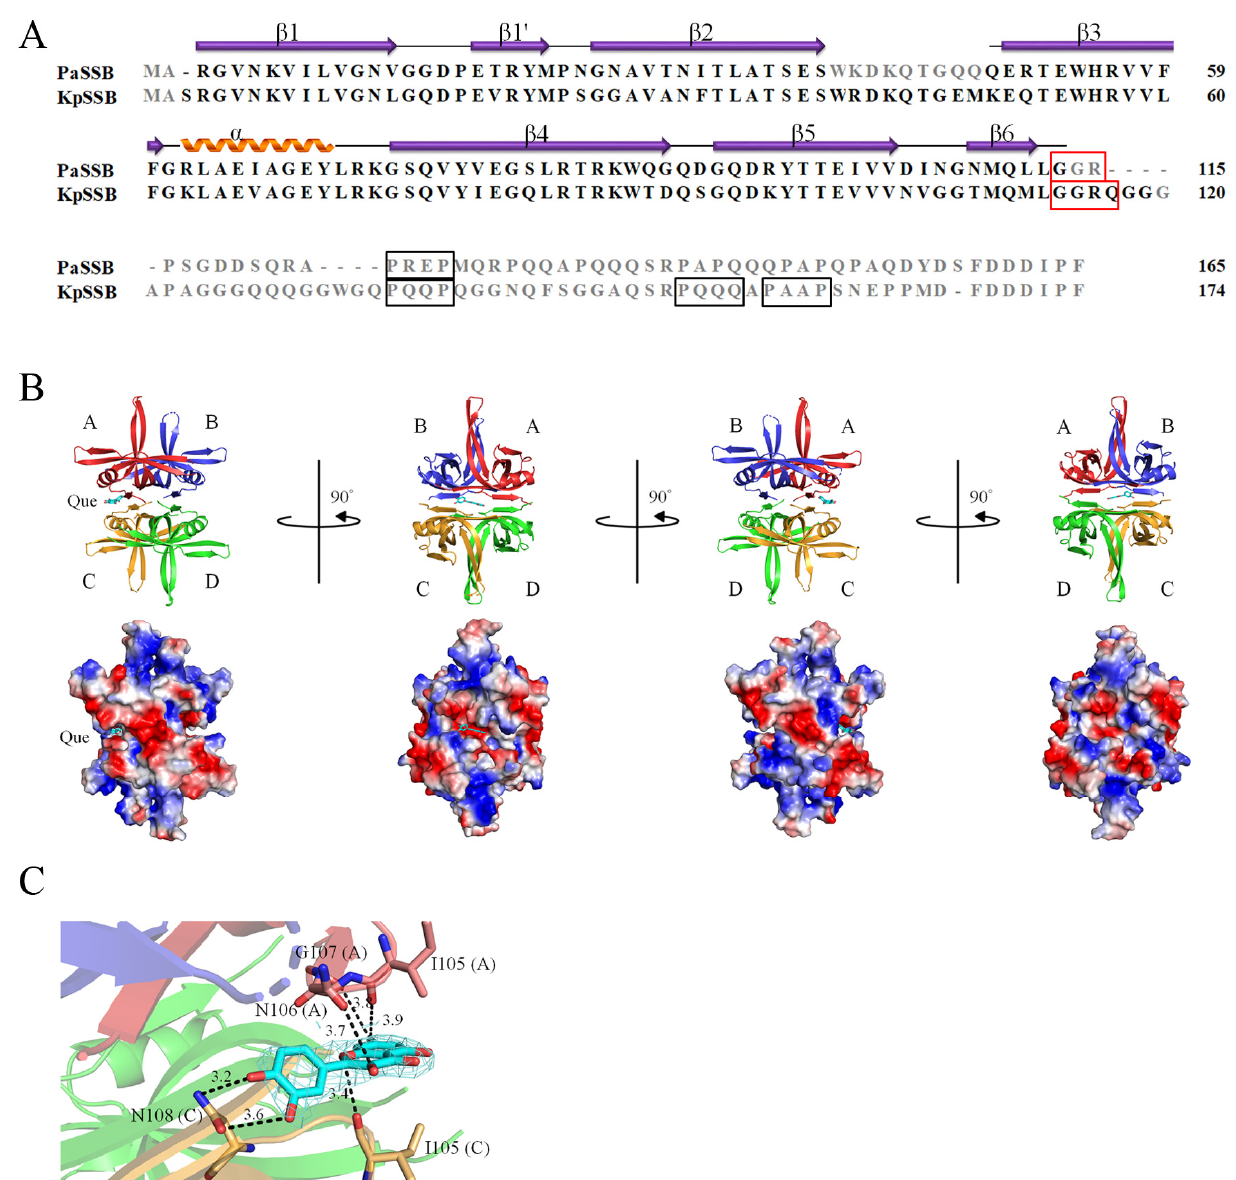
* Values in parentheses are for the highest resolution shell. R sym = Σ |I − ‘I’|/ Σ I, where I is the ob ‐ served intensity and ‘I’ is the statistically weighted average intensity of multiple observations of symmetry ‐ related reflections.